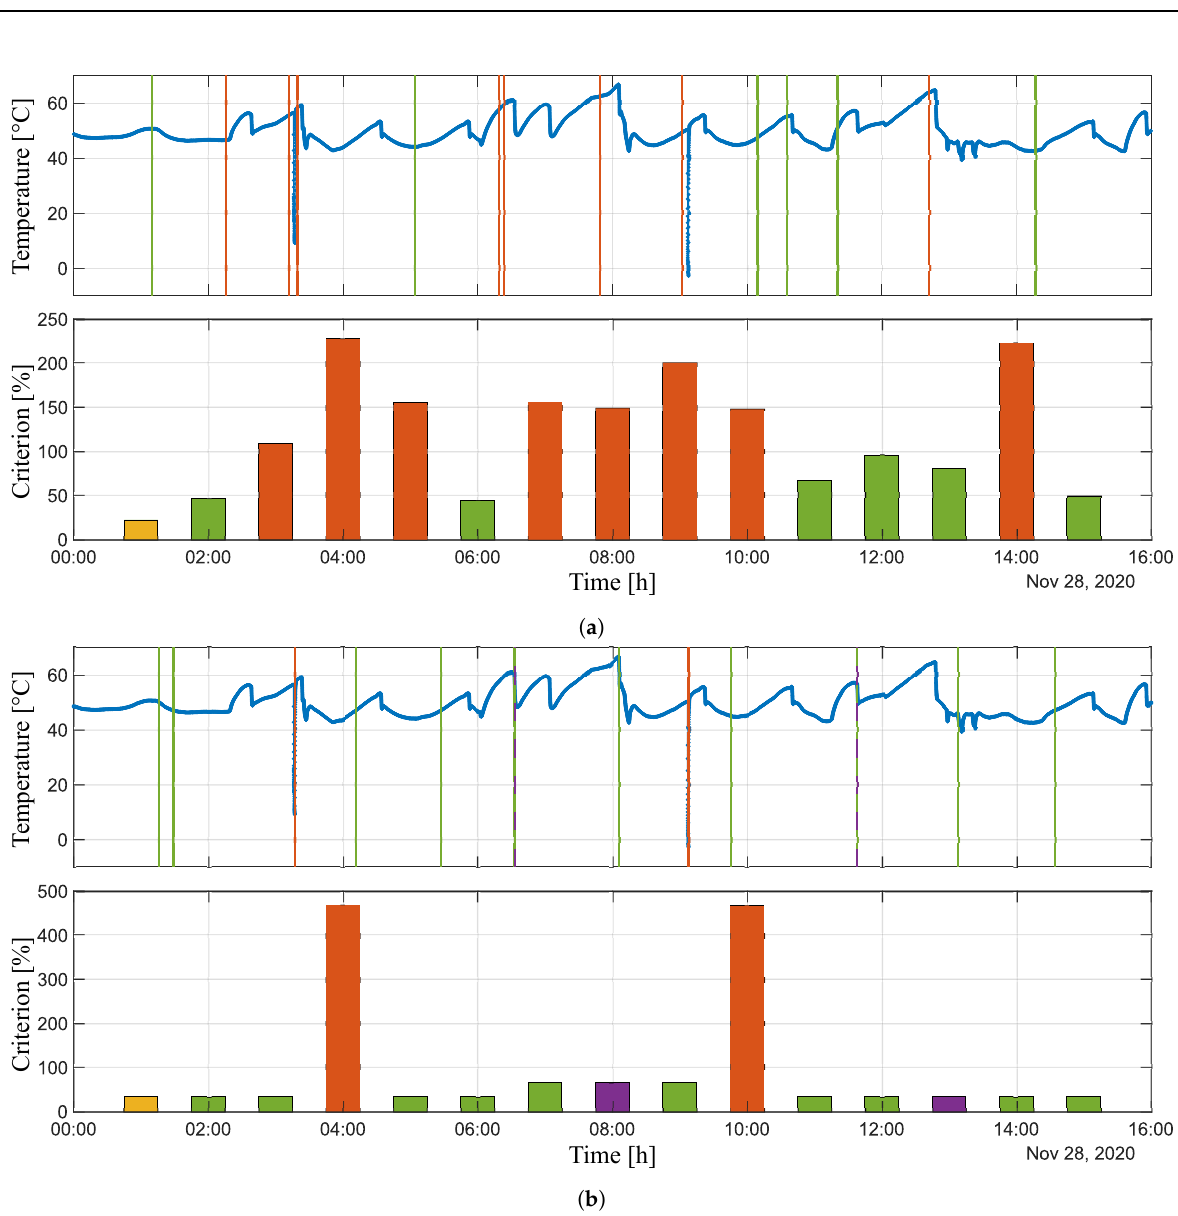
Figure 7. Experimental results of cfn:: T1.1_out0 variable. ( a ) Signal evaluation and oscillation analysis. ( b ) Signal evolution and sudden change